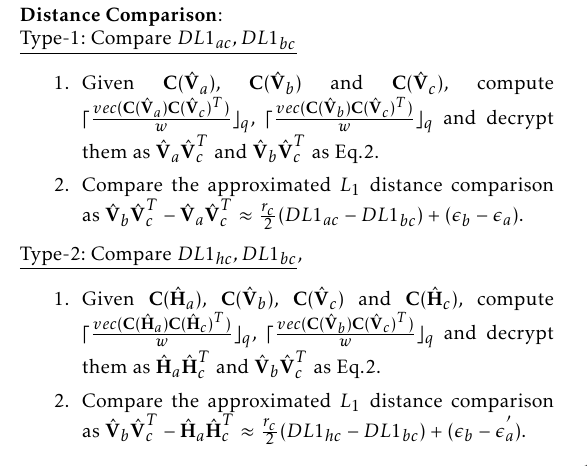
Figure 3. Construction of P L 1 C − RF